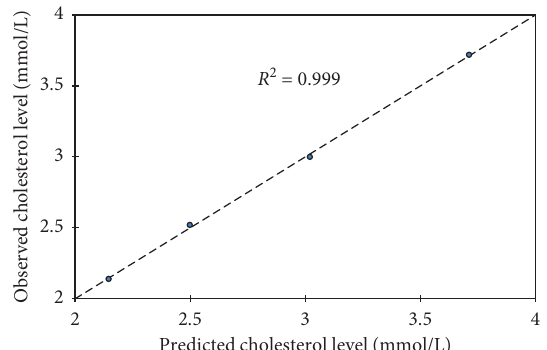
Figure 10: Predicted triglyceride level against observed as a lipid profile parameter, where y � triglyceride levels and x � Costus afer concentrations served as input